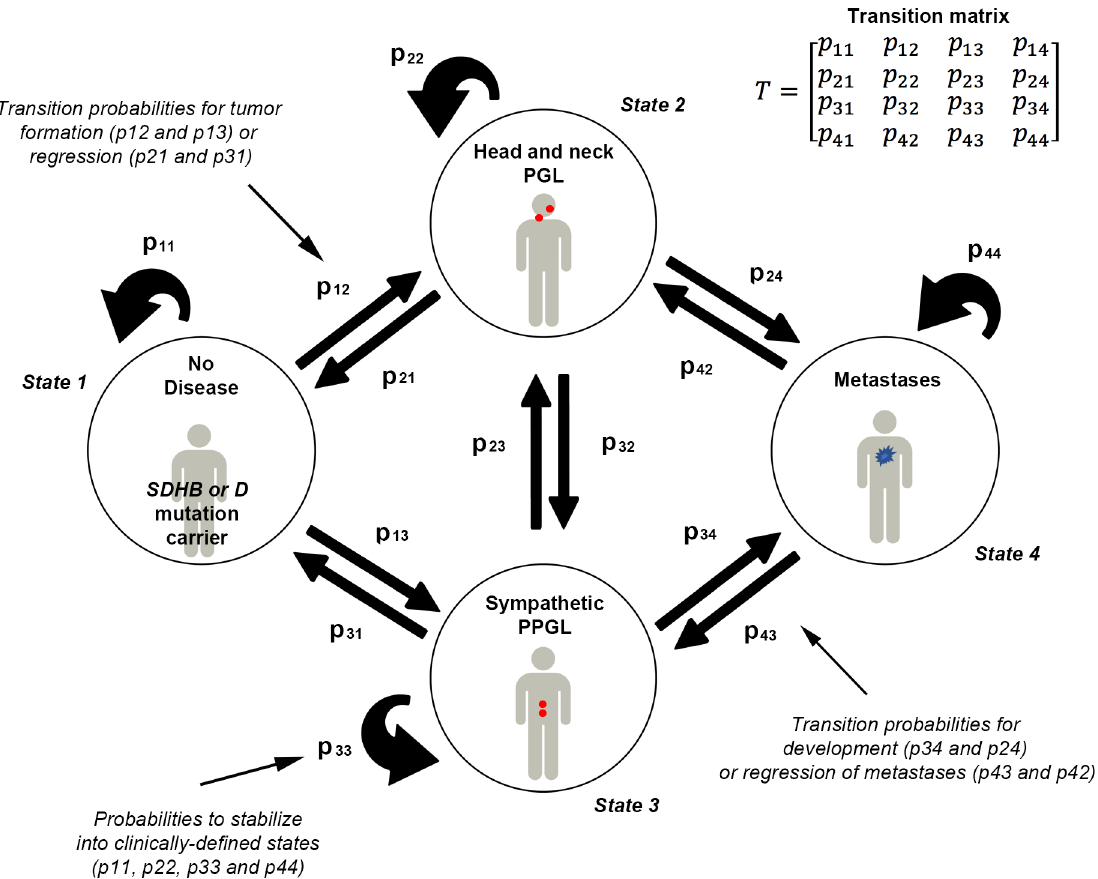
Fig 3. Disease scenarios and rules of disease dynamics. Four clinical states and 16 transition probabilities between states are represented (using Markov chains). Population-level transition probabilities are represented in the 4–4 matrix T (i.e with 4 rows and 4 columns, upper right). The transition probabilities are denoted by p probability to stay in this state i . Numerical values for transition probabilities are given in Table 1. According to international nomenclature of stochastic matrix, the row vector of the Markov chains has been written in order to meet the following criteria: non negative coefficients and the sum of each row equal to 1.